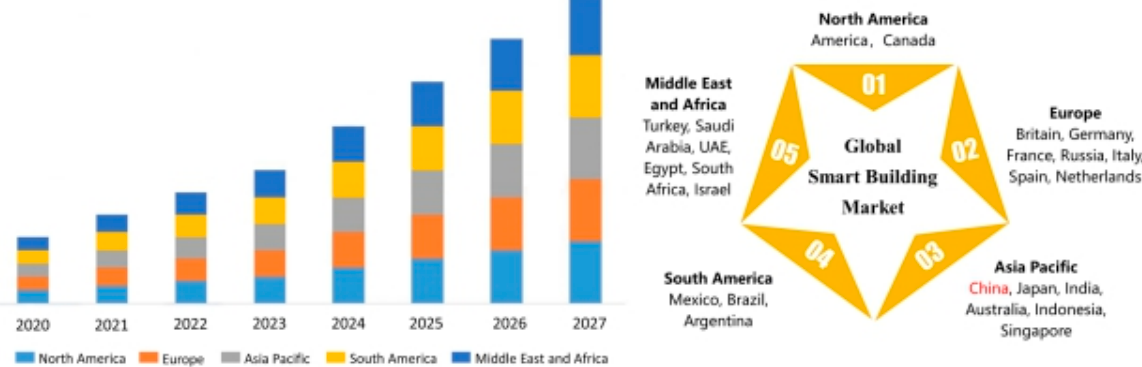
Figure 2. The smart building market size of the regions and countries globally.